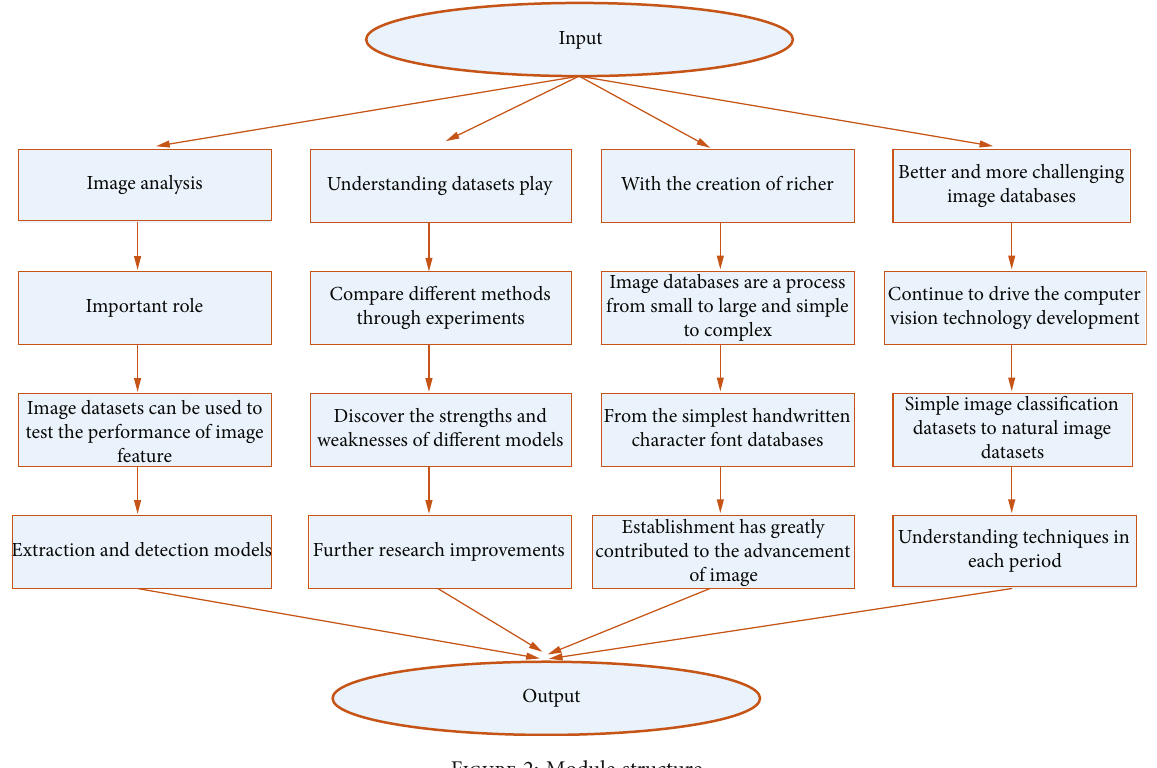
Figure 2: Module